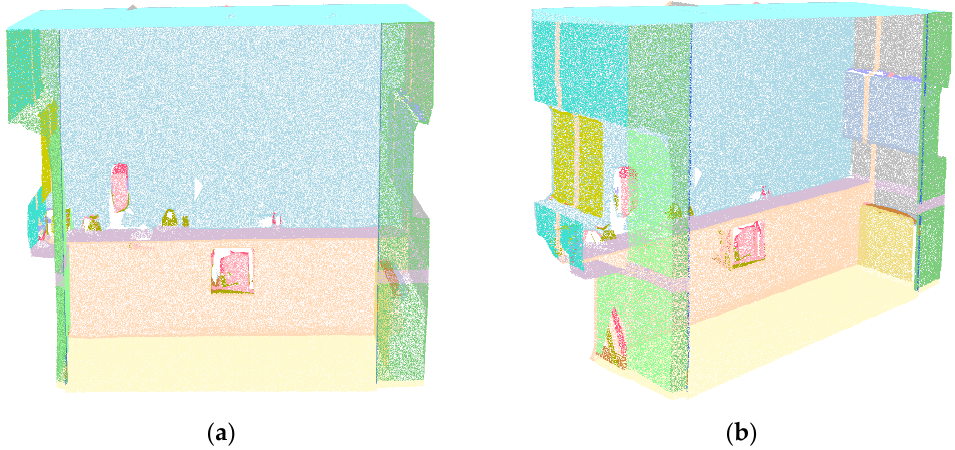
Figure 10. Pantry’s segmentation results using the RANSAC algorithm: ( a ) front view and ( b ) side view.